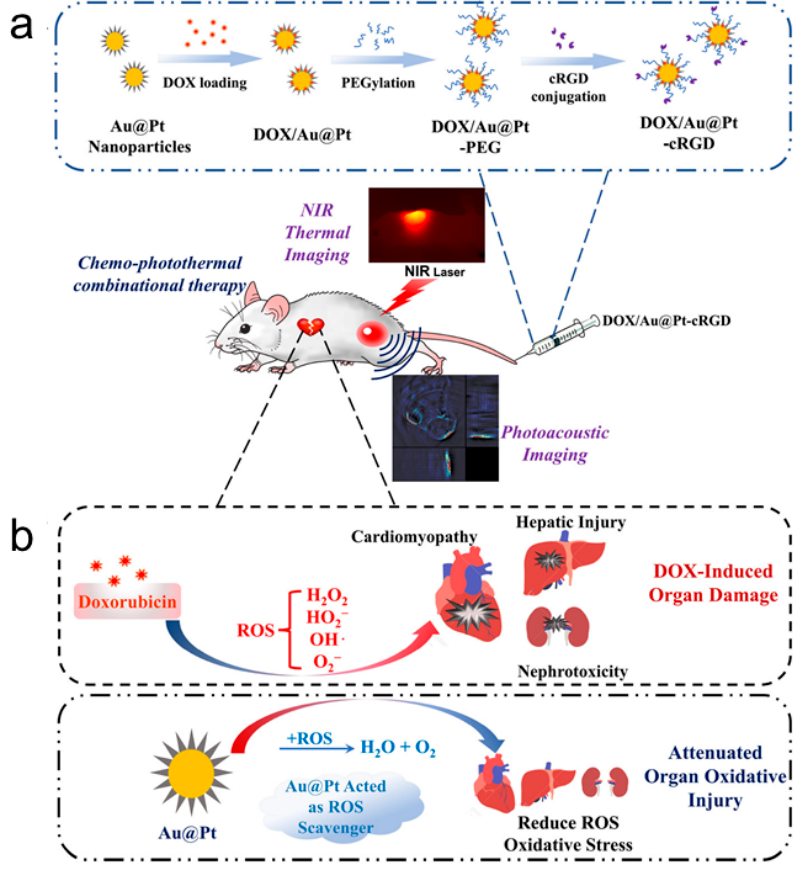
Figure 12. Schematic illustrations of ( a ) the synthesis of DOX/Au@Pt-cRGD, and ( b ) ROS scavenging by catalyzing the platinum shell while attenuating DOX-induced organ oxidative injury. Reproduced with permission from ref. [95]. Copyright 2017 American Chemical Society.